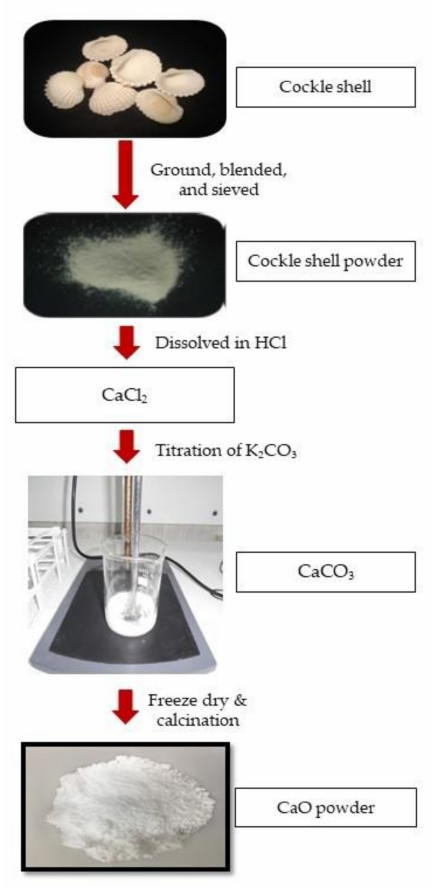
Figure 1. Schematic diagram of CaCO 3 and CaO synthetic